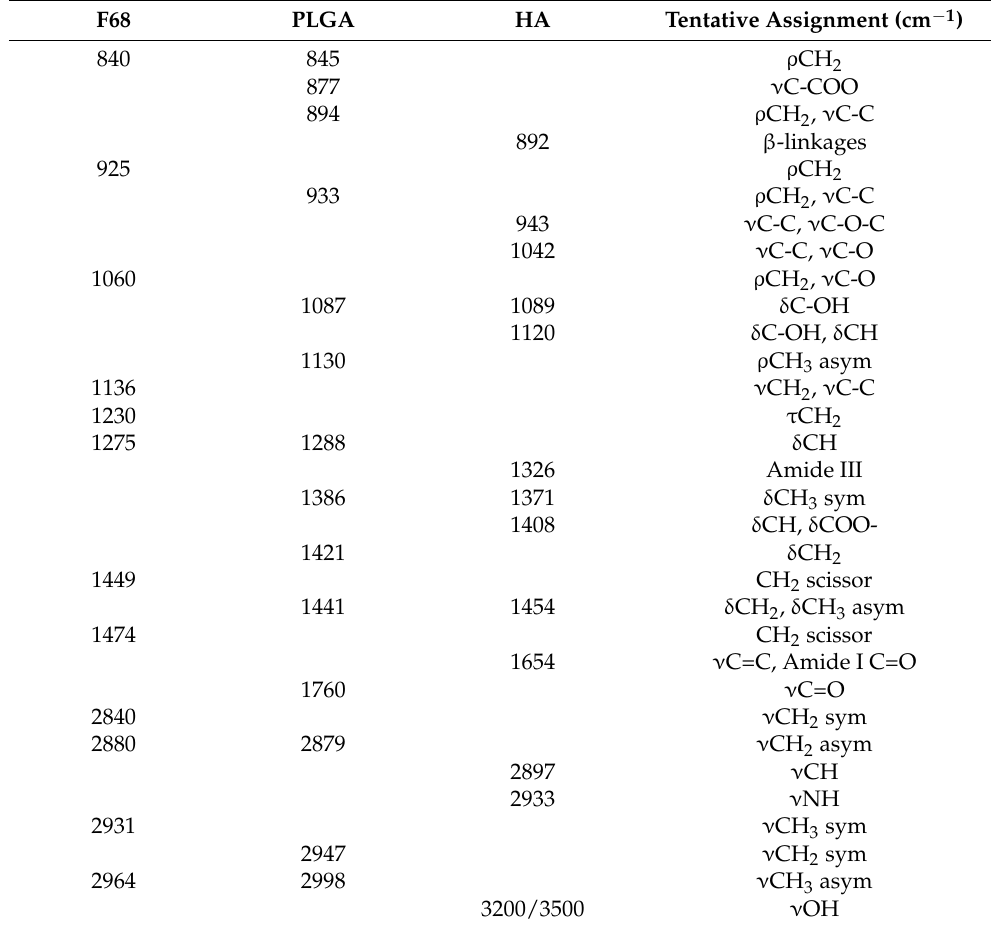
Table 2. Raman assignments of F68, PLGA, and HA ( ν = stretching, ρ = rocking, δ = bending, τ = twist). F68 PLGA HA Tentative Assignment (cm − 1 ) 840 845 ρ CH 2 877 ν C-COO 894 ρ CH 2 , ν C-C 892 β -linkages ρ CH 2 ρ CH ν C-C 2 , ν C-C, ν